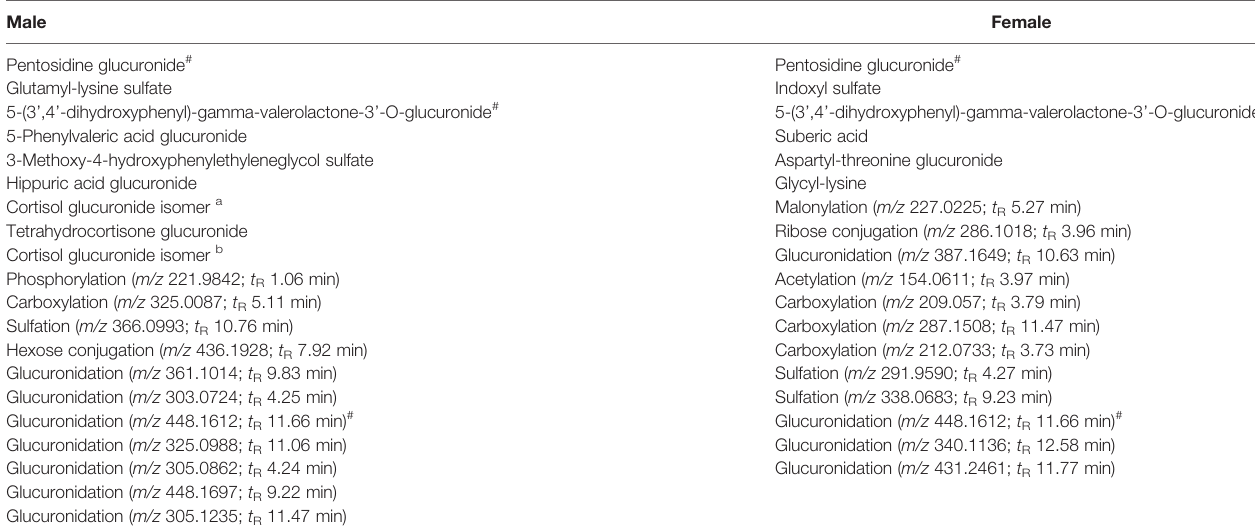
TABLE 2 | List of sex-speci fi c biomarkers of modi fi ed metabolites in the diagnostic patterns for prediabetes screening in urine of male and female subjects (further analytical characteristics about each modi fi ed metabolite are given in Supplementary Tables 3A, B ). Male Pentosidine glucuronide